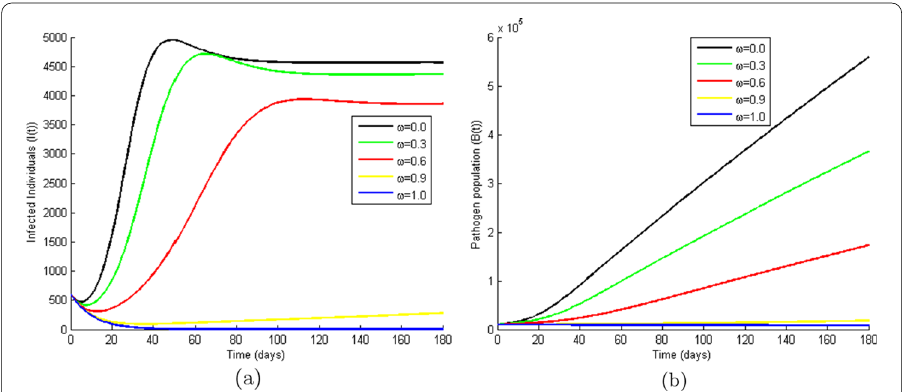
Fig. 2 The impact of treatment on a infected individual and b pathogen